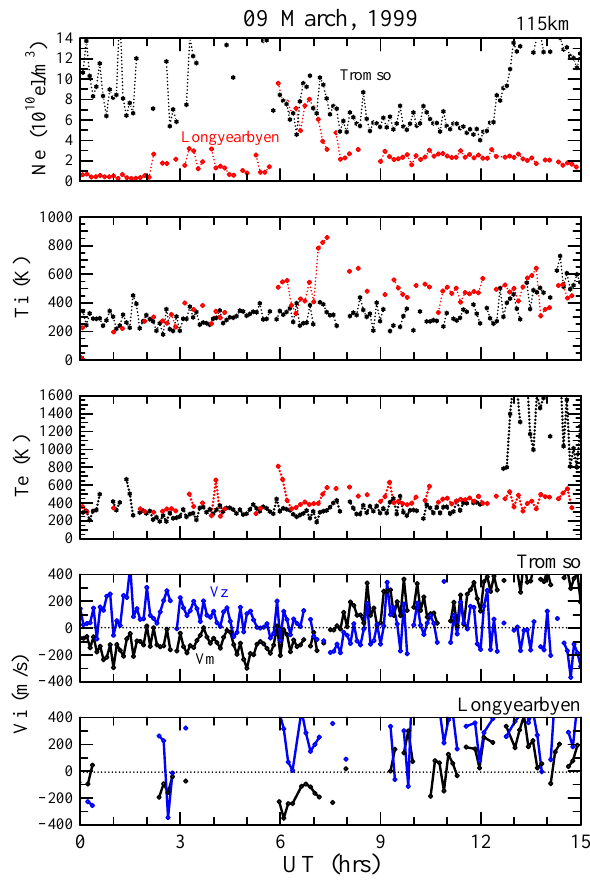
Fig. 5. Same parameters as Fig. 4 except for 9 March